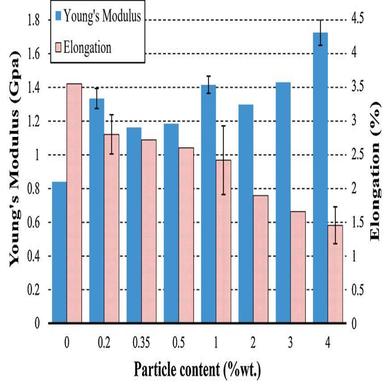
Young's modulus and elongation results of samples with different particle contents.